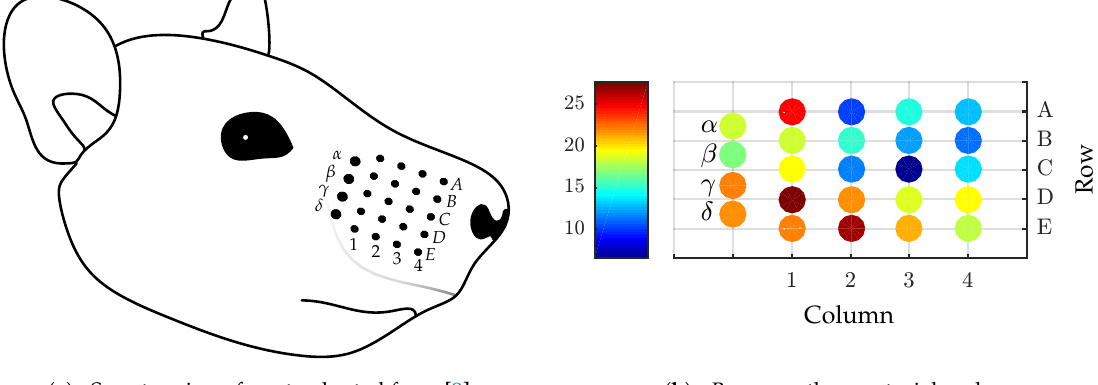
Figure 1. ( a ) Schematic drawing of the mystacial pad of a rat. A black dot corresponds to a single vibrissa, the vibrissae shafts are excluded from the illustration. ( b ) Change of the Reynolds number across the mystacial pad with respect to the mean diameter of each vibrissa and v = 5 m the Young’s modulus of the vibrissa is set to 3 GPa, the density of the vibrissa ρ v = 1140 kg of air ρ f = 1.2 kg and the kinematic viscosity ν = 1.5 × 10 − 5 m 2 m 3